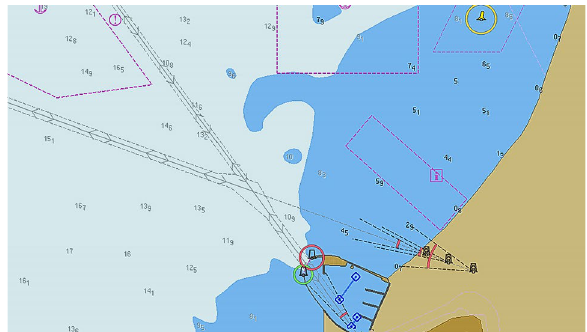
Figure 1. The approach channel to the Port of Ventspils